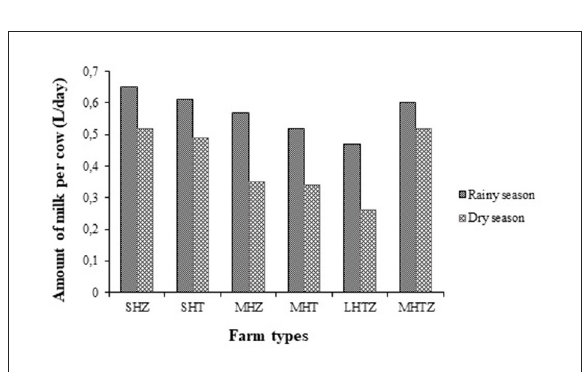
FIGURE6 Daily amount of milk collected per cow present in the herd across dairy cattle farm types in peri-urban areas of south Benin.